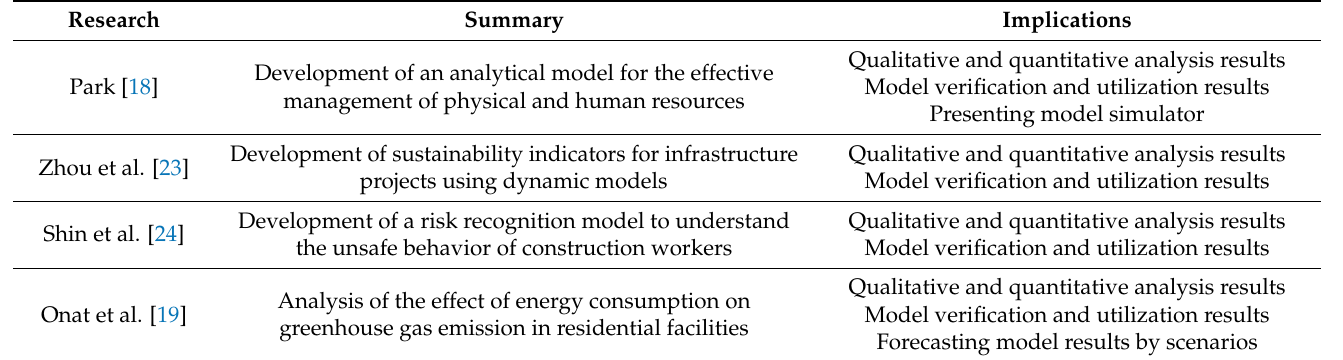
Table 2. Literature research on construction using overseas system